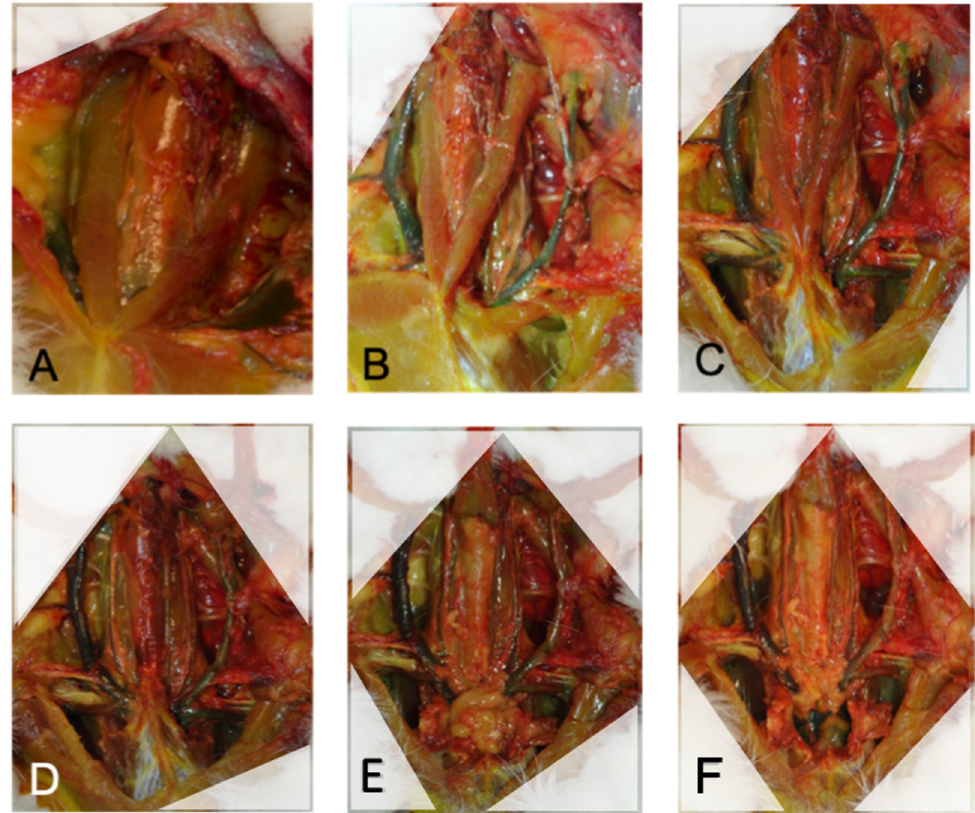
Figure 2. Illustration of the dissection step by step. ( A ) After median skin incision and fat pad resection. ( B ) After removal of the lDPM and first rib on the left side. ( C ) After removal of the rDPM and first rib on the right side. ( D ) After section and reclination of both SCM. ( E ) After section and reclination of the STM. ( F ) After dissection of the heart cavity. Note the reclined SCM/STM in the white triangles in ( D – F ).